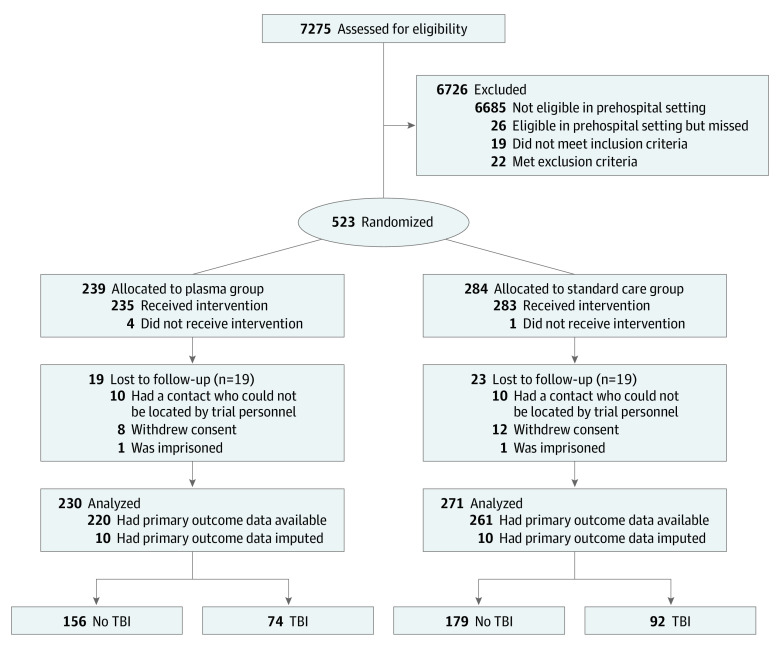
Patient Selection FlowchartTBI indicates traumatic brain injury.